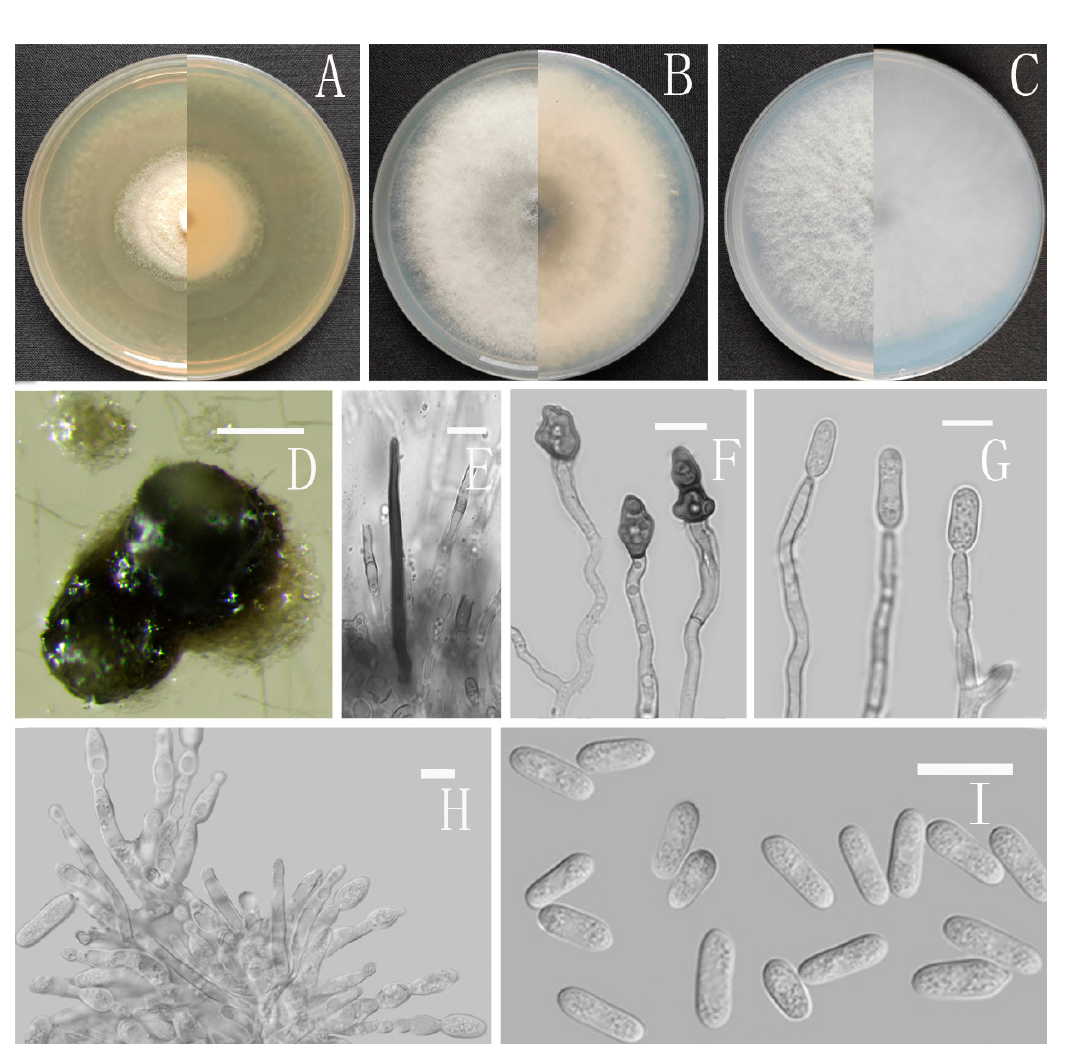
Figure 15. Colletotrichum yunajiangense (YMF1.04996). ( A – C ) Colonies on media above and below after 7 days at 25 °C (( A ) MEA; ( B ) PDA; ( C ) SNA). ( D ) Conidiomata. ( E ) Setae. ( F ) Appressoria. ( G ) Conidiophores. ( H ) Conidiophores and Conidia. ( I ) Conidia. Scale bars: ( D ) = 100 μ m, ( E – I ) = 10 μ m. Additional specimen examined: China, Yunnan province, Yuanjiang county, from disease spot of Ageratina adenophora , August 2017, Han-Bo Zhang, living culture YMF 1.04997.